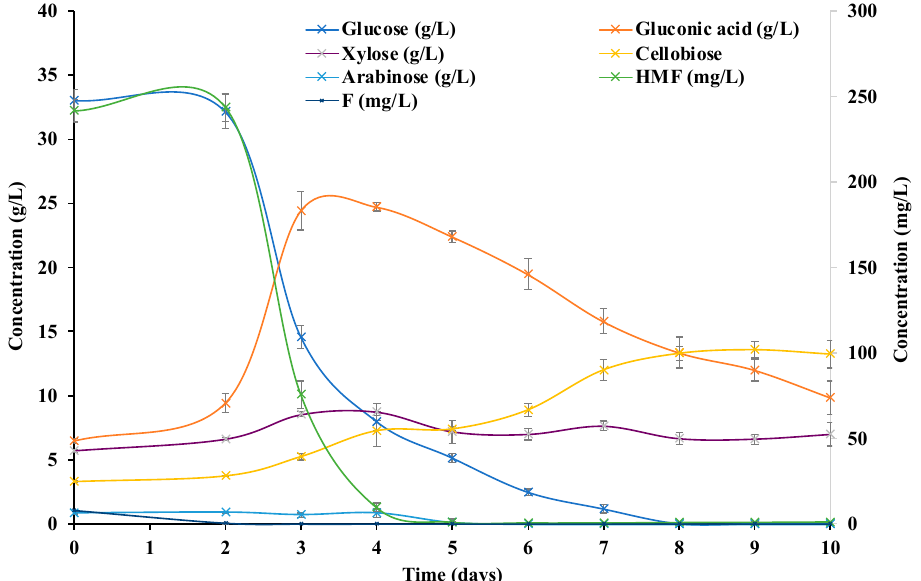
Figure 1. Cellobiose, gluconic acid, glucose, xylose, arabinose, 5-(hydroxymethyl)-2-furaldehyde (HMF) and furfural (F) concentration (g/L; mg/L) of the bagasse–potato culture medium during the incubation time. Values are shown as means and standard deviations.